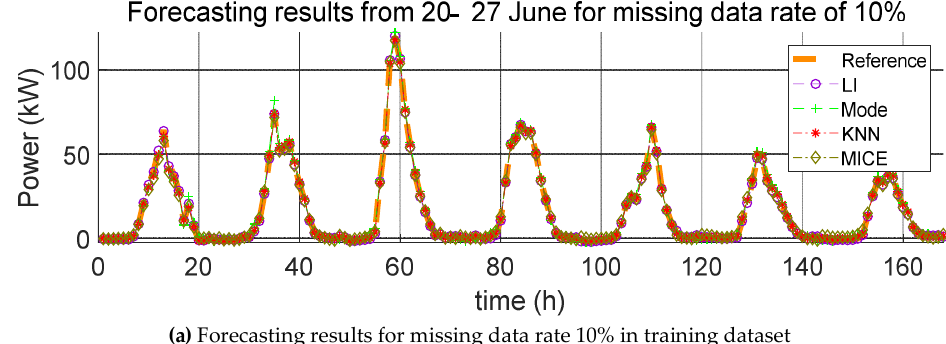
Figure 7. Forecasting results from 20 – 27 March for various missing data rates (10%, 15%, and 20%).